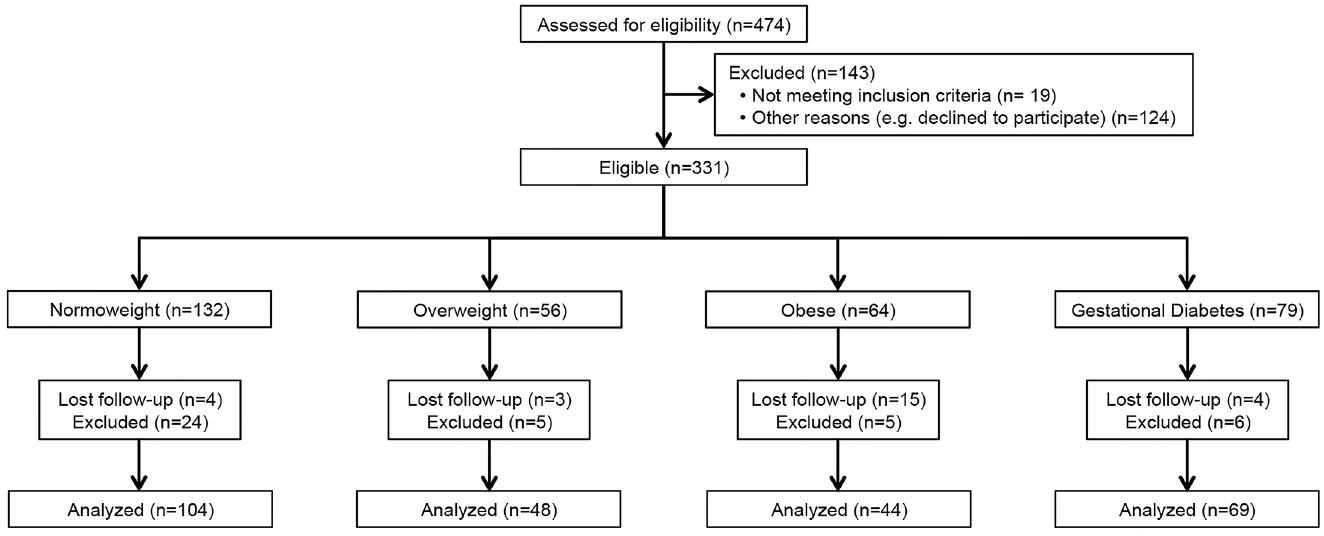
Fig 1. Participants in the PREOBE study and classification following BMI and gestational diabetes criteria.